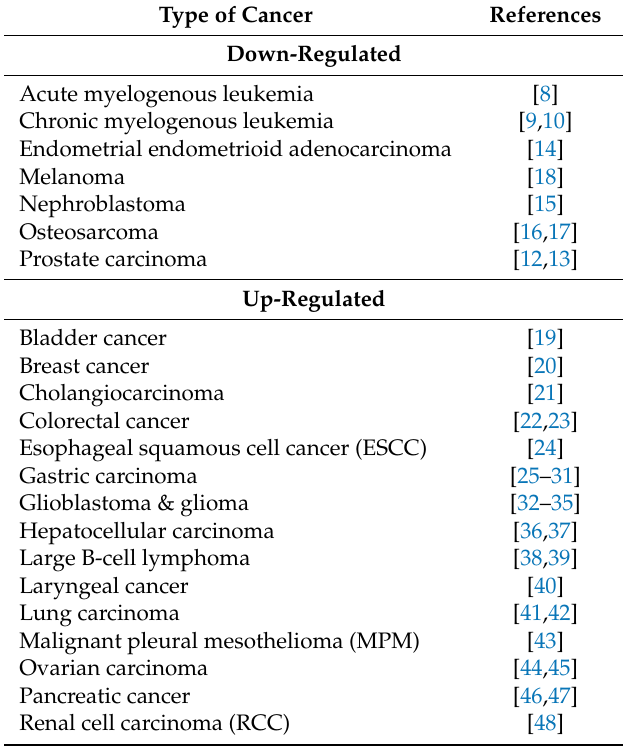
Table 1. Expression pattern of microRNA-23a (miR-23a) in different types of human cancer. Type of